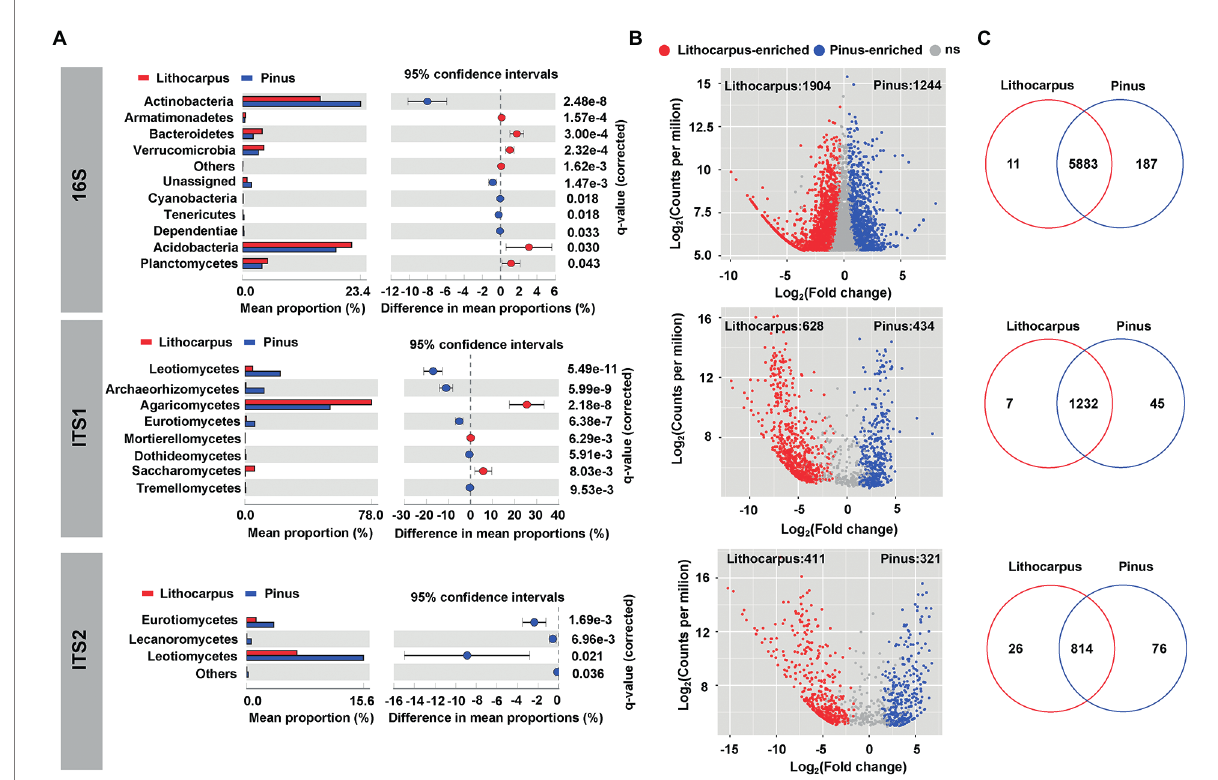
FIGURE 3 Tree species shape the microbial composition of ECM roots. (A) Differential abundance of bacterial and fungal OTUs in Lithocarpus and Pinus ECM roots. Welch’s tests followed by Benjamini-Hochberg FDR corrections were performed between Lithocarpus and Pinus ECM roots at phylum (bacterial OTUs) and class (fungal OTUs) levels. (B) The volcano plot shows the enriched OTUs in Lithocarpus and Pinus ECM roots. Each dot represents a single OTU. Each red dot represents an individual enriched OTUs in Lithocarpus ECM roots and each blue dot represents an individual enriched OTUs in Pinus ECM roots. The x-axis represents the fold-change in abundance and the y-axis represents the average OTUs abundance (in counts per million, CPM). (C) Venn diagrams showing the shared and specific bacterial and fungal OTUs among Lithocarpus and Pinus ECM roots. The ITS1 sequences used for this analysis were produced from samples harvested during both the dry and wet